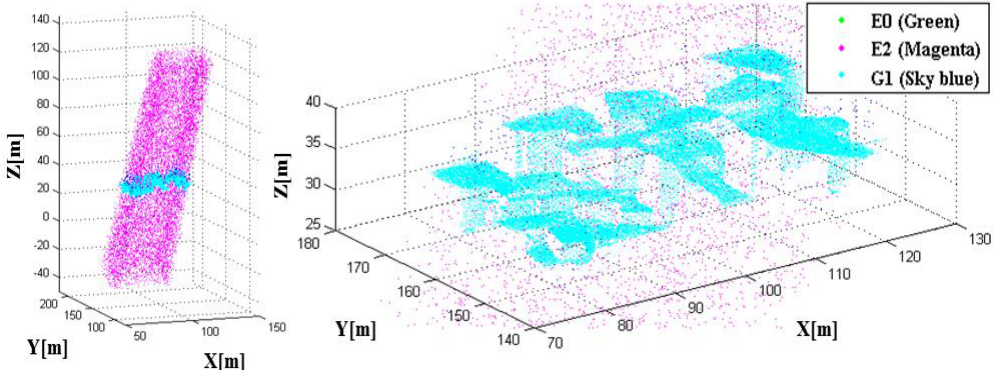
Figure 22. Simulated point cloud color-coded by case—E0: green, E2: magenta and G1: sky blue.